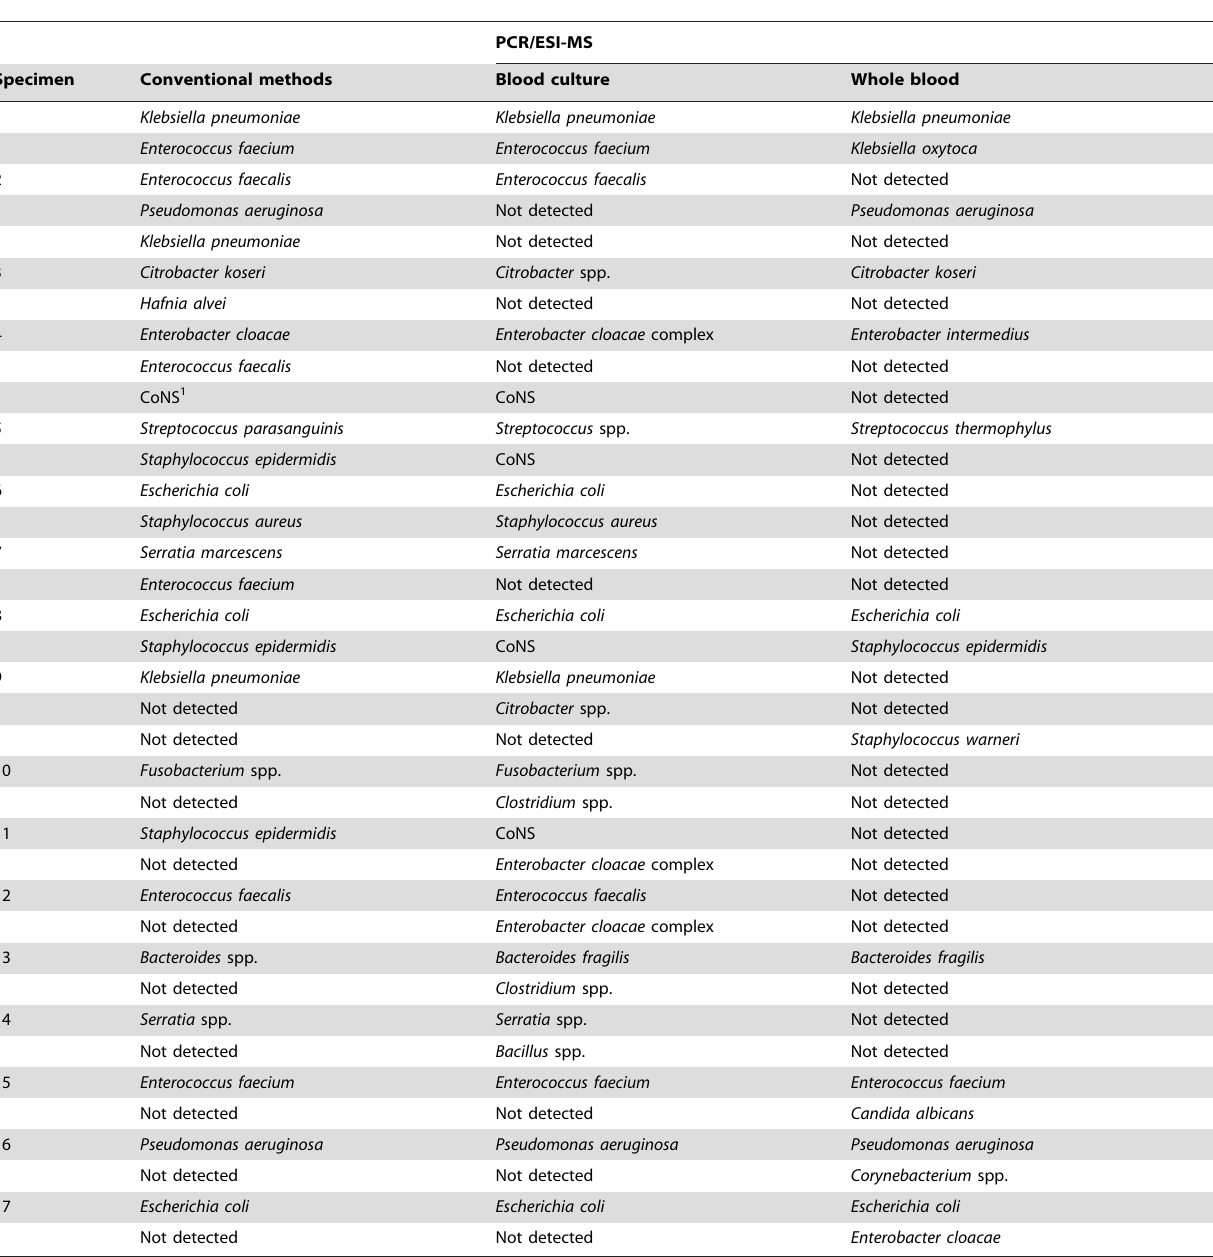
Table 2. Polymicrobial infections/detections by conventional methods or PCR/ESI-MS according to specimen